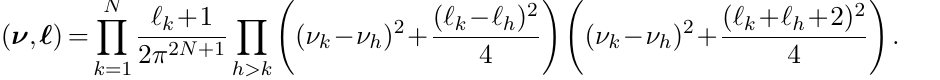
) 0 , x 0 0 , x 1 , x 0 1